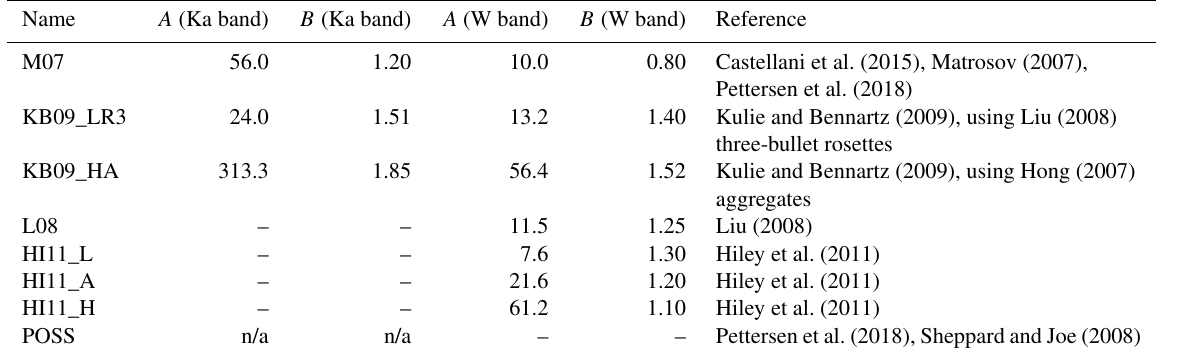
Table 1. Parameters of Ka-band (MMCR) Z – S relations and W band (CloudSat) used in this study. The POSS operates at X band so that the Z – S relation is not directly comparable to the Z – S relations for MMCR. A Z – S relationship is defined as Z = AS B where S is the